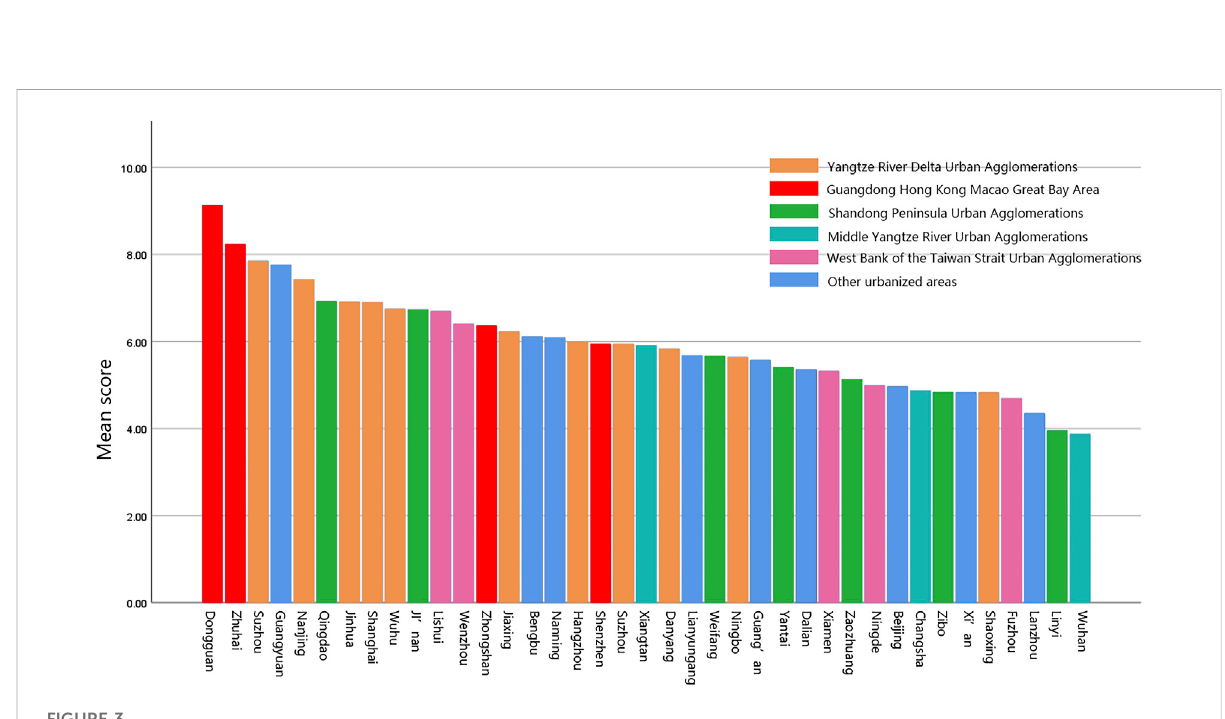
FIGURE 3 Scores divided by urban